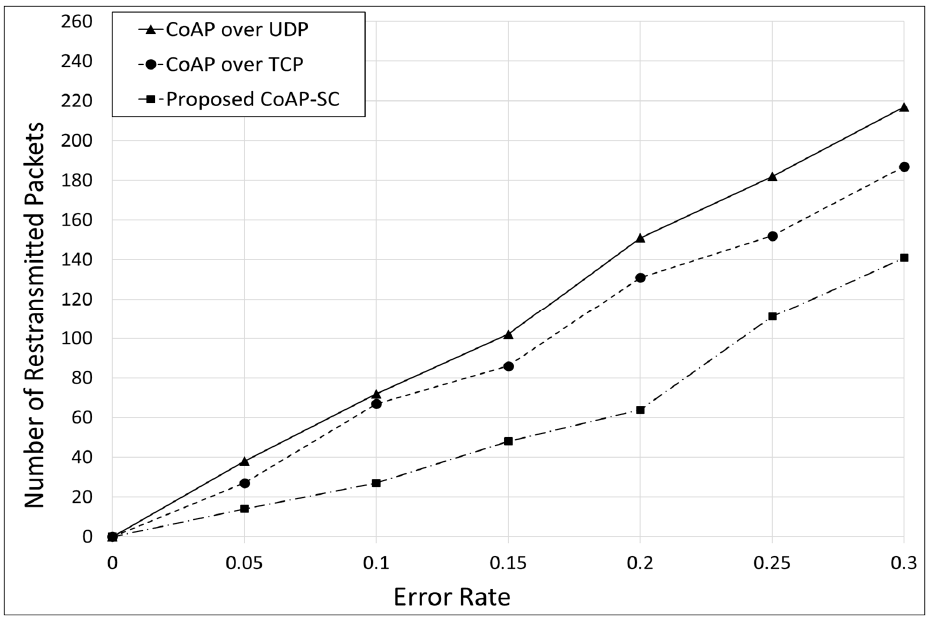
Figure 19. Number of retransmitted packets for different error rates.